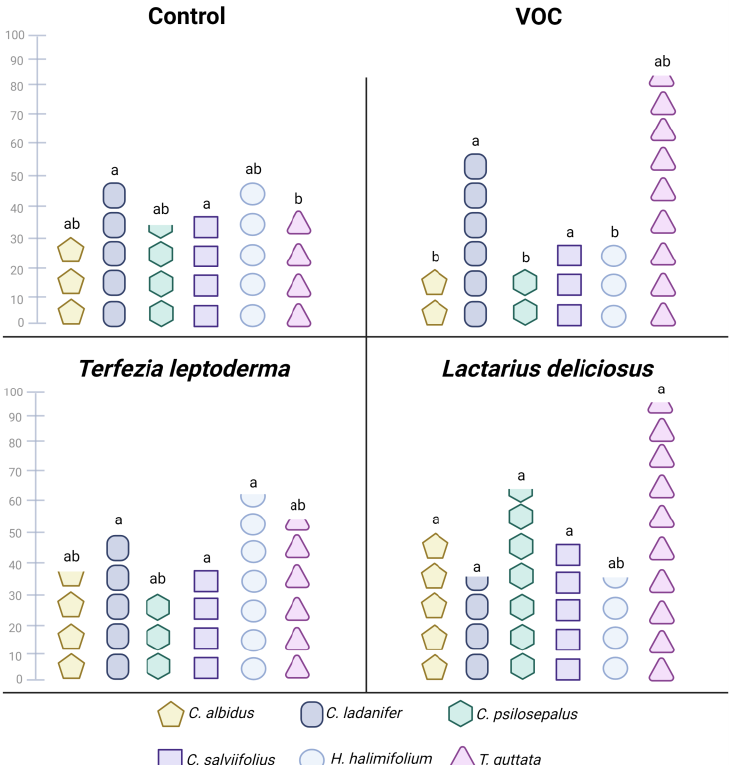
Figure 4. Effects of 1-octen-3-ol 1 µ M (VOC) and ECM mycelium ( T. leptoderma and L. deliciosus ) on Cistaceae germination rates (%, N = 5). Data were compared using a Kruskall–Wallis test. Post hoc comparisons were made using a Dunn’s test. Data are means. Different letters show significant differences ( p < 0.05) between treatments for each Cistaceae species.